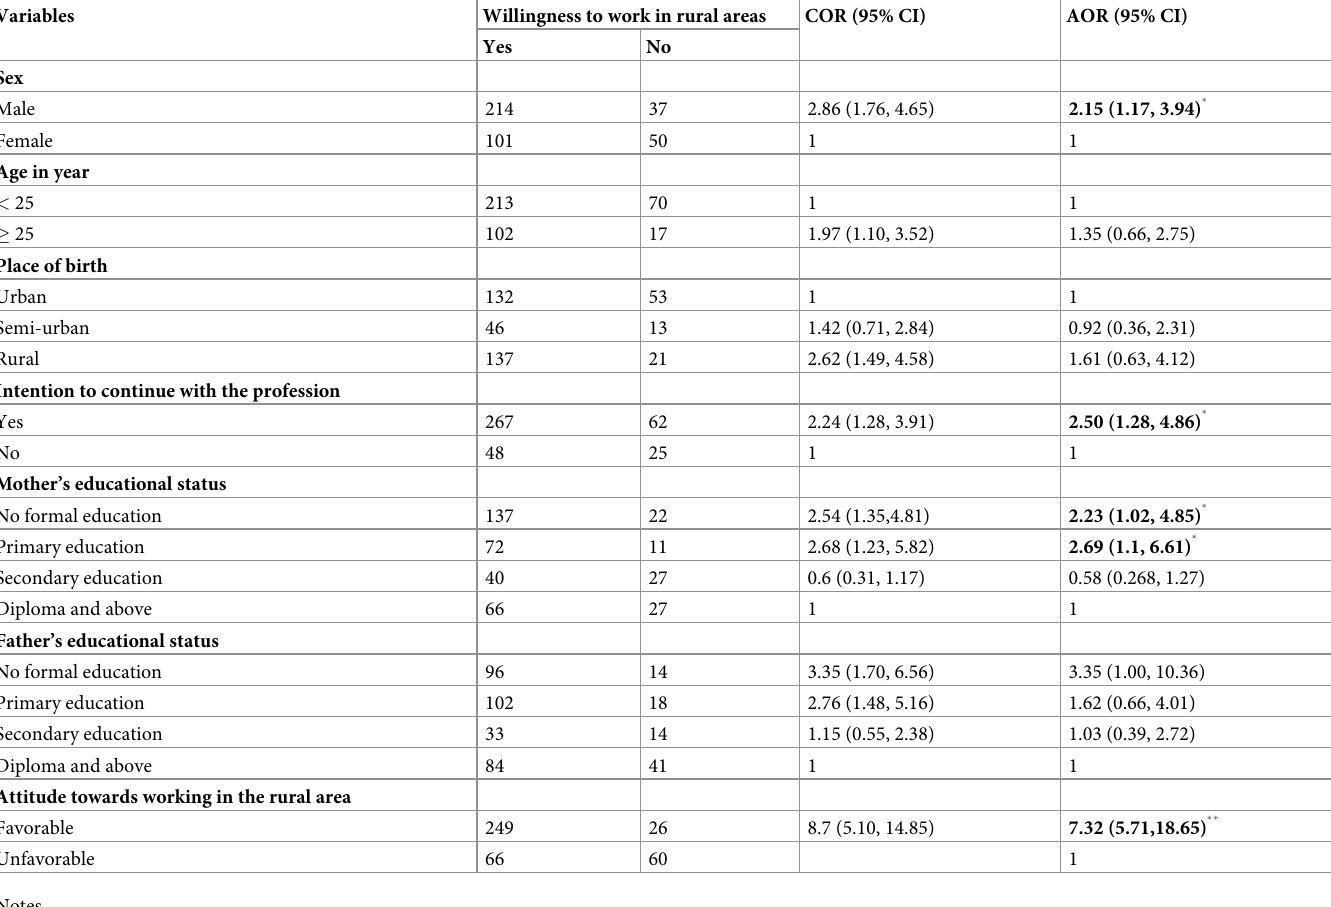
Table 3. Bivariable and multivariable logistic regression analysis of factors associated with graduating students willingness to work in rural areas in the University of Gondar, northwest Ethiopia, 2021 (n =